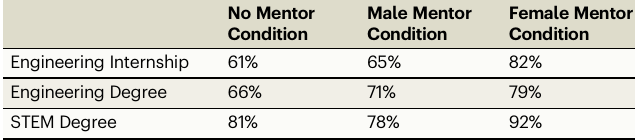
Table 1 depicts thepercentageofparticipants (separatedbycondition) who obtainedengi- neering internshipsat some point incollege, as well as the percentageofparticipants who obtaineda Bachelor ’ s degree inengineeringinparticular orSTEM in